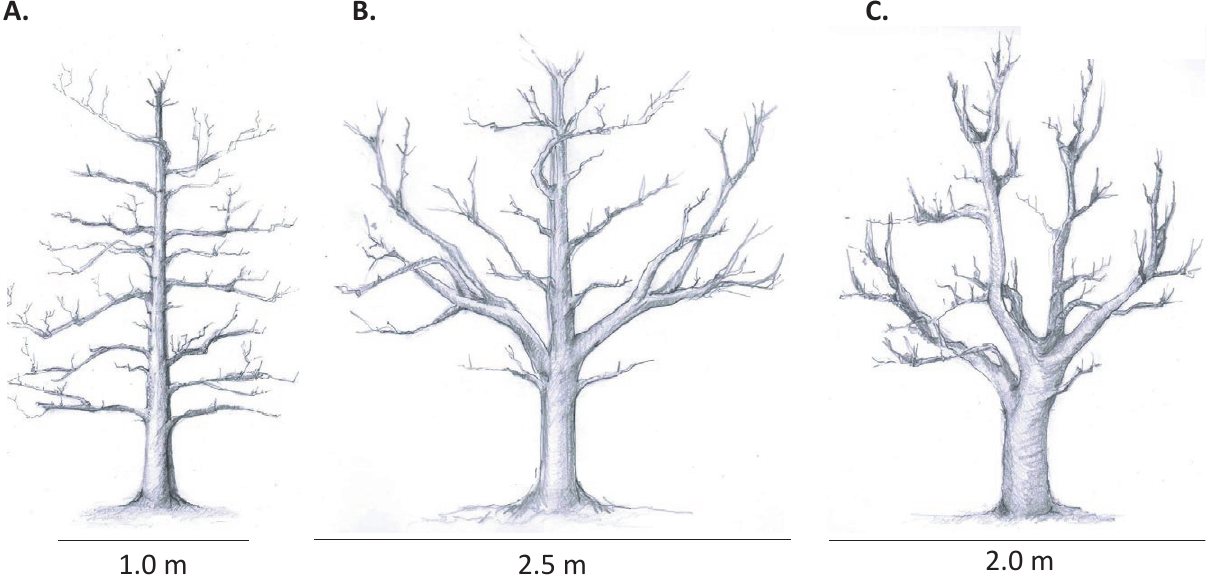
Figure 1. The tree design systems tested in this study. Schematic drawings of 7-year-old trees are shown. (A) ‘Spadona‘ and ‘Coscia‘ high- density system, spindle design; (B) ‘Spadona‘ low-density system, palmeta design; (C) ‘Coscia’ low-density system, open vase design. Illus- tration: Reut